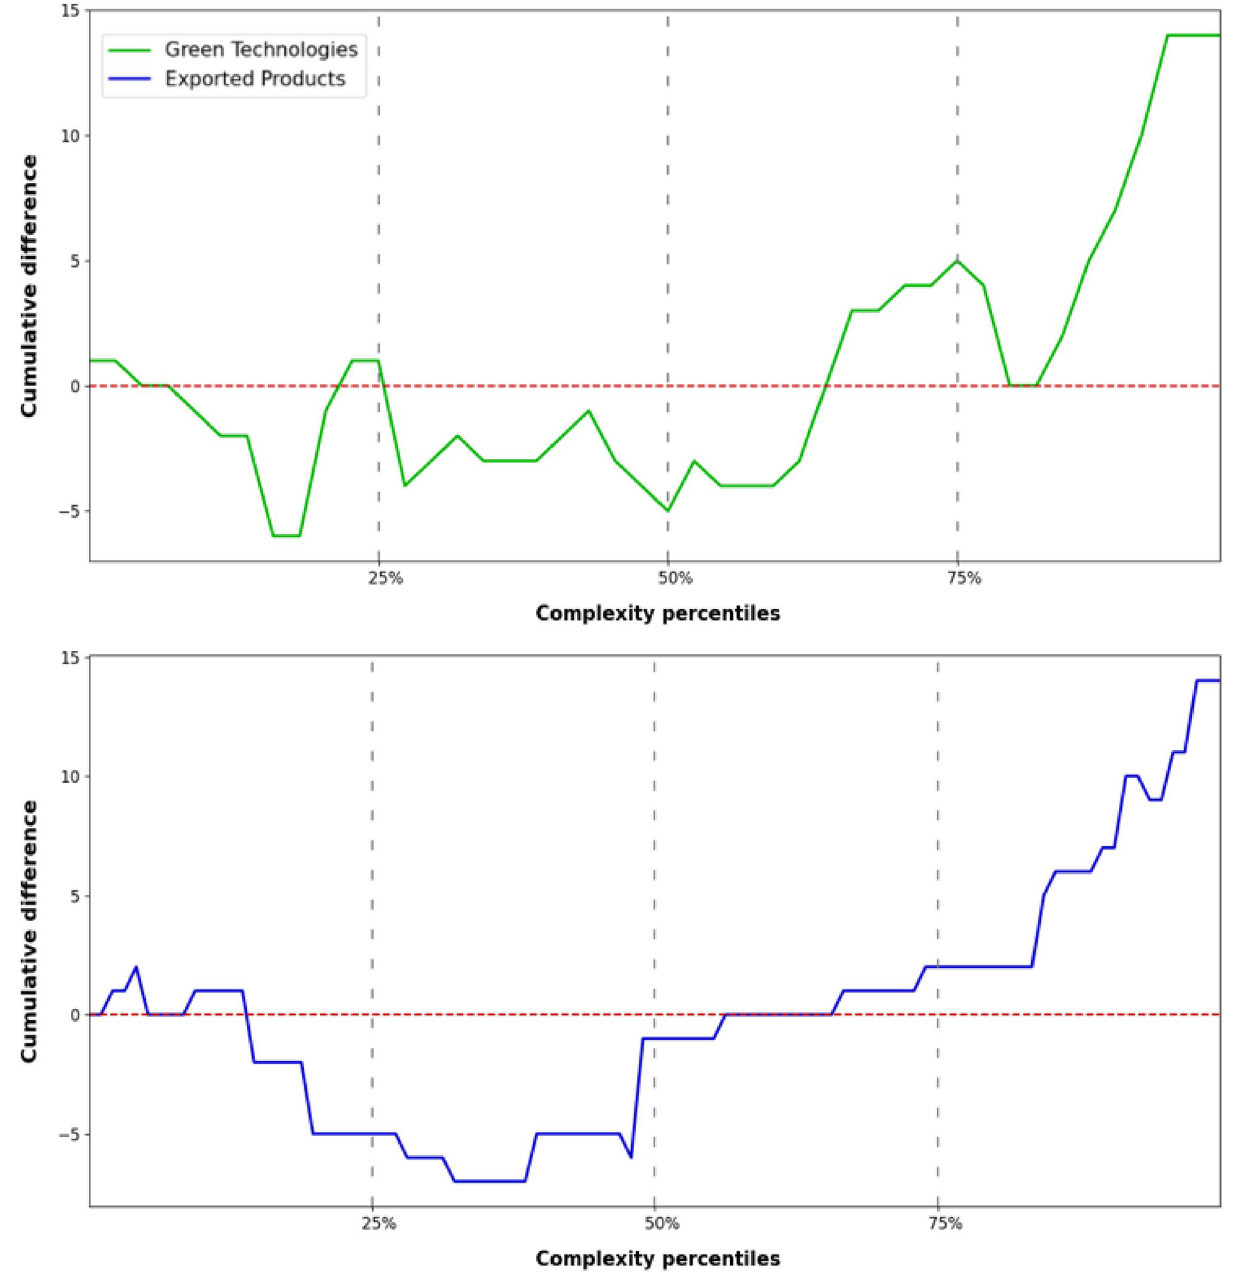
Figure 5. Cumulative difference between the number of node links for the time lag (cid:31) T = 10 and (cid:31) T = 0 . The top panel refers to green technologies (green line), while the bottom panel (blue line) refers to 2-digit exported products. In their respective panel, green technologies and exported products are sorted in order of increasing complexity ranking. The x-axis labels 25%, 50% and 75% delimit the first, second and third quartiles of the complexity ranking (moving from the last to the first position). If the y-value is below/above 0 (dashed red line), then the cumulative number of links delimited by the corresponding green technology or product in the x-axis is higher for � T = 0 /� T = 10